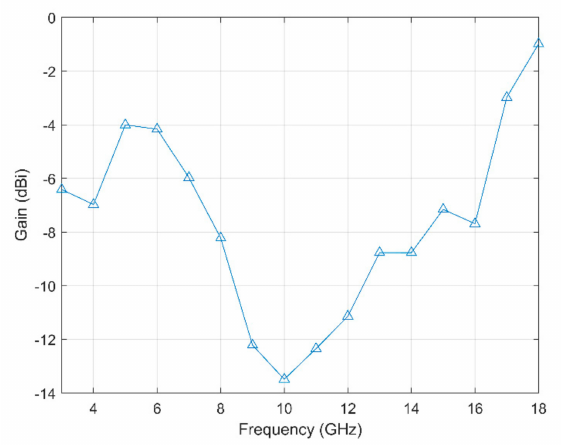
Figure 5. Measured gain of the transparent antenna under various